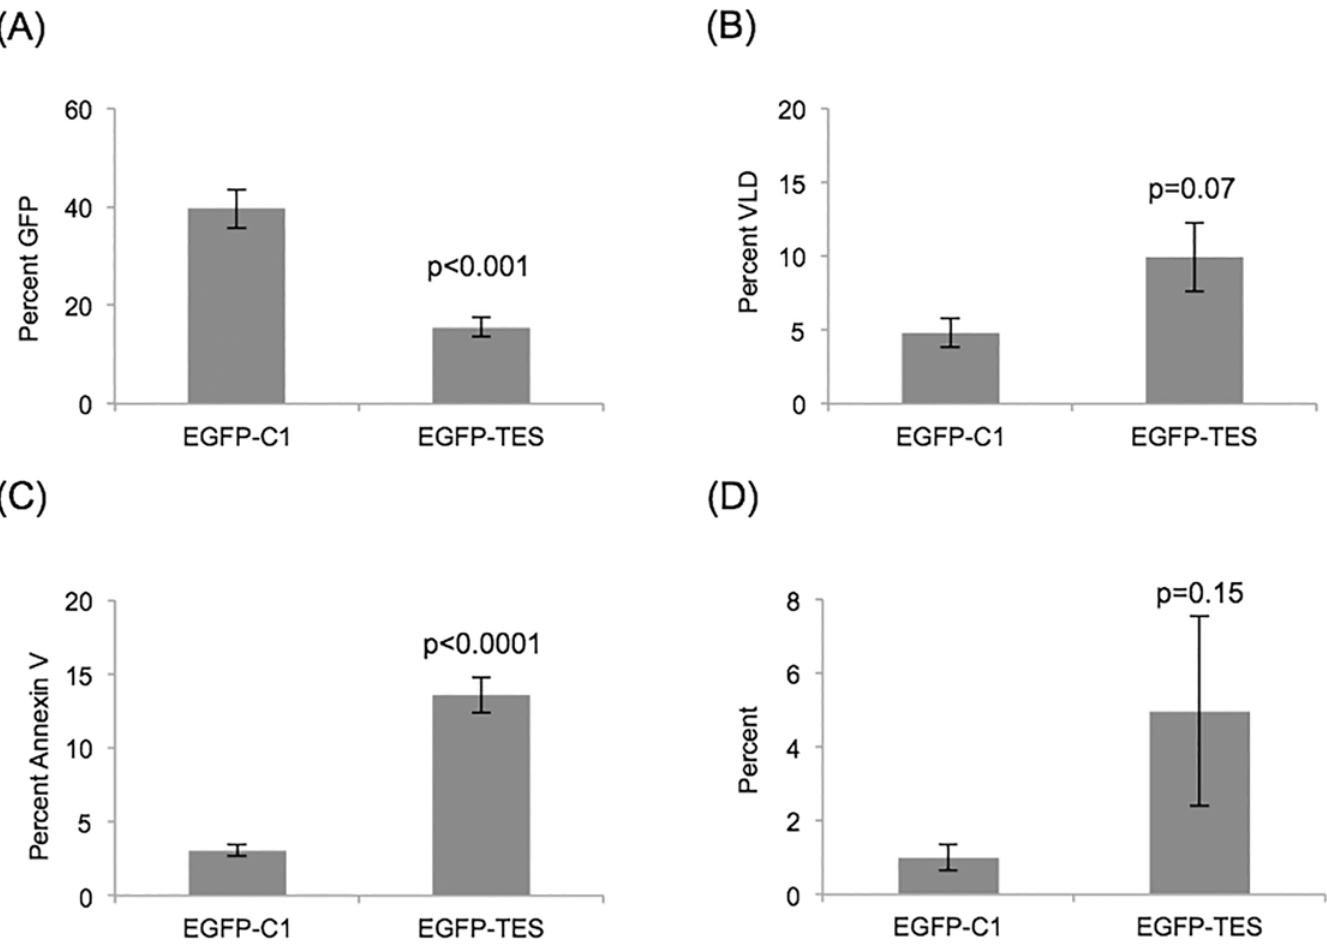
Fig 4. Flow cytometry results showing reduced numbers of GFP-positive NALM6 cells and increased cell death after pEGFP-TES transfection. Transfected NALM6 cells (24 hours post-transfection) were labelled with Annexin V and VLD and analysed by flow cytometry. (A) Decreased numbers of GFP-positive NALM6 cells were present after pEGFP-TES transfection (p < 0.001). After gating for GFP fluorescence, increased numbers of cells are (B) VLD positive (p = 0.07), (C) Annexin V positive (p < 0.0001) and (D) Annexin V positive and VLD negative (p = 0.15) (n = 5; error bars are standard errors; significance values were calculated using unpaired, two-tailed, Student ’ s